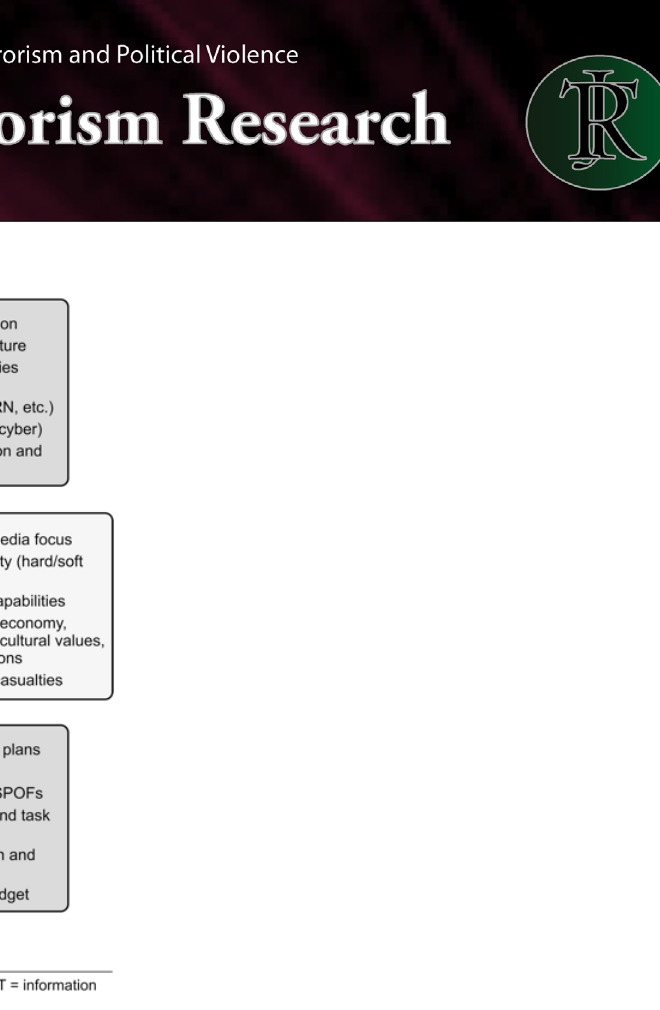
Figure 4: Typical components of terrorist attack